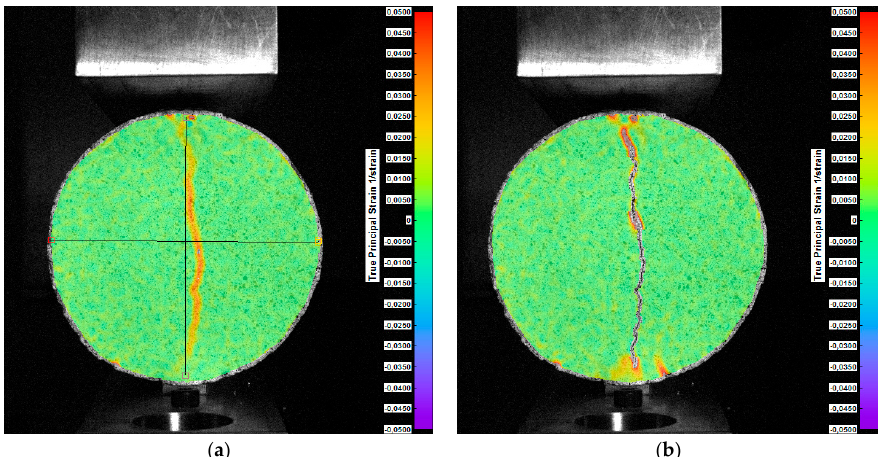
Figure 15. Maps of maximal true principal strains of the soil sample surface in the indirect tensile test: ( a ) Phase immediately before cracking; ( b ) sample with cracks [41].